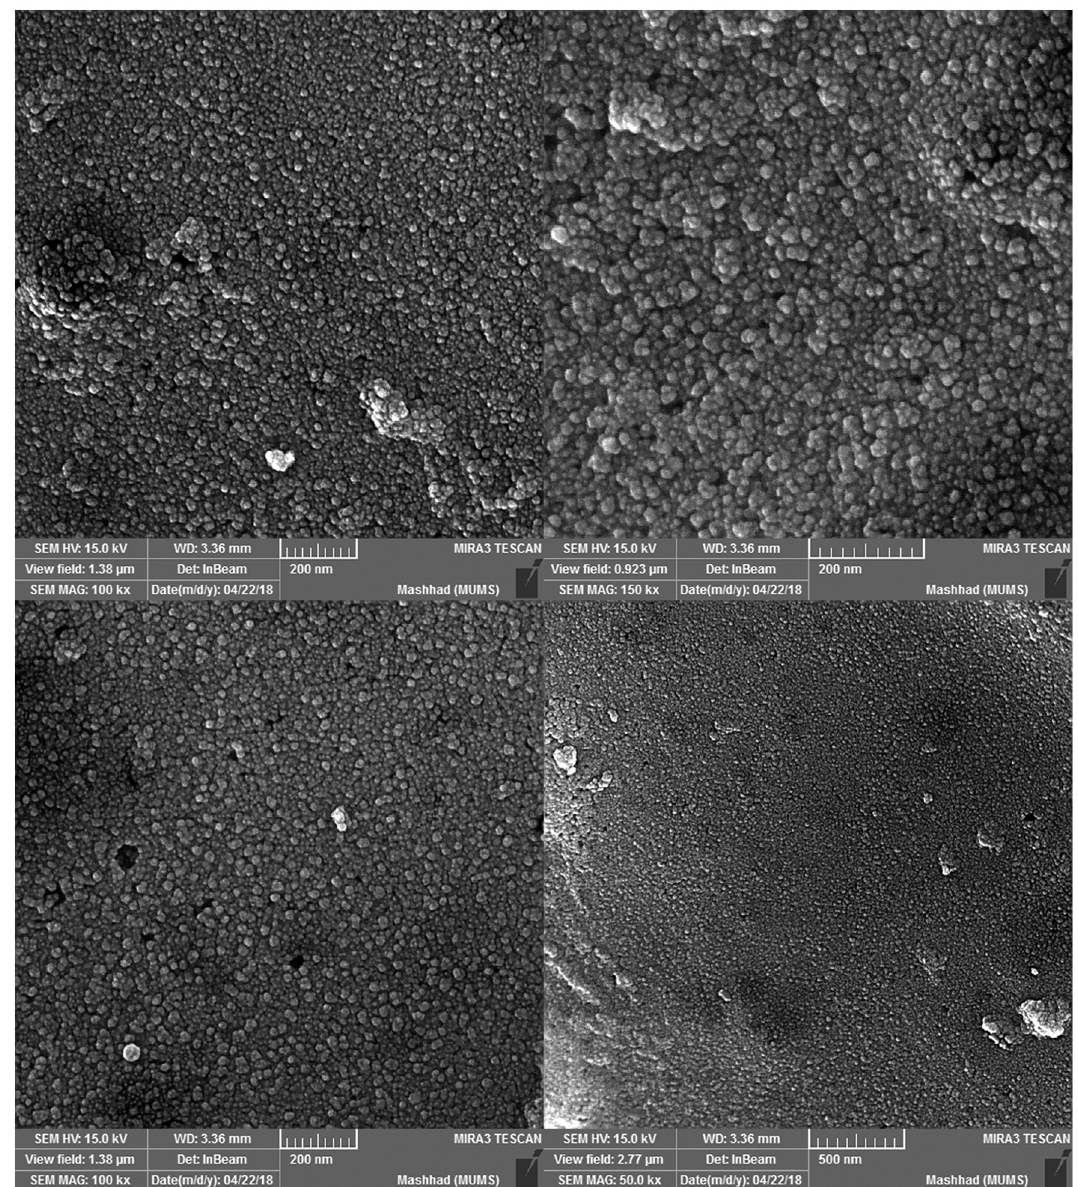
Figure 11: SEM images of SrTiO nanoparticle synthesis autocombustion that calcinate at 500°C. 3 orange in 60 min about 95% were degraded. These